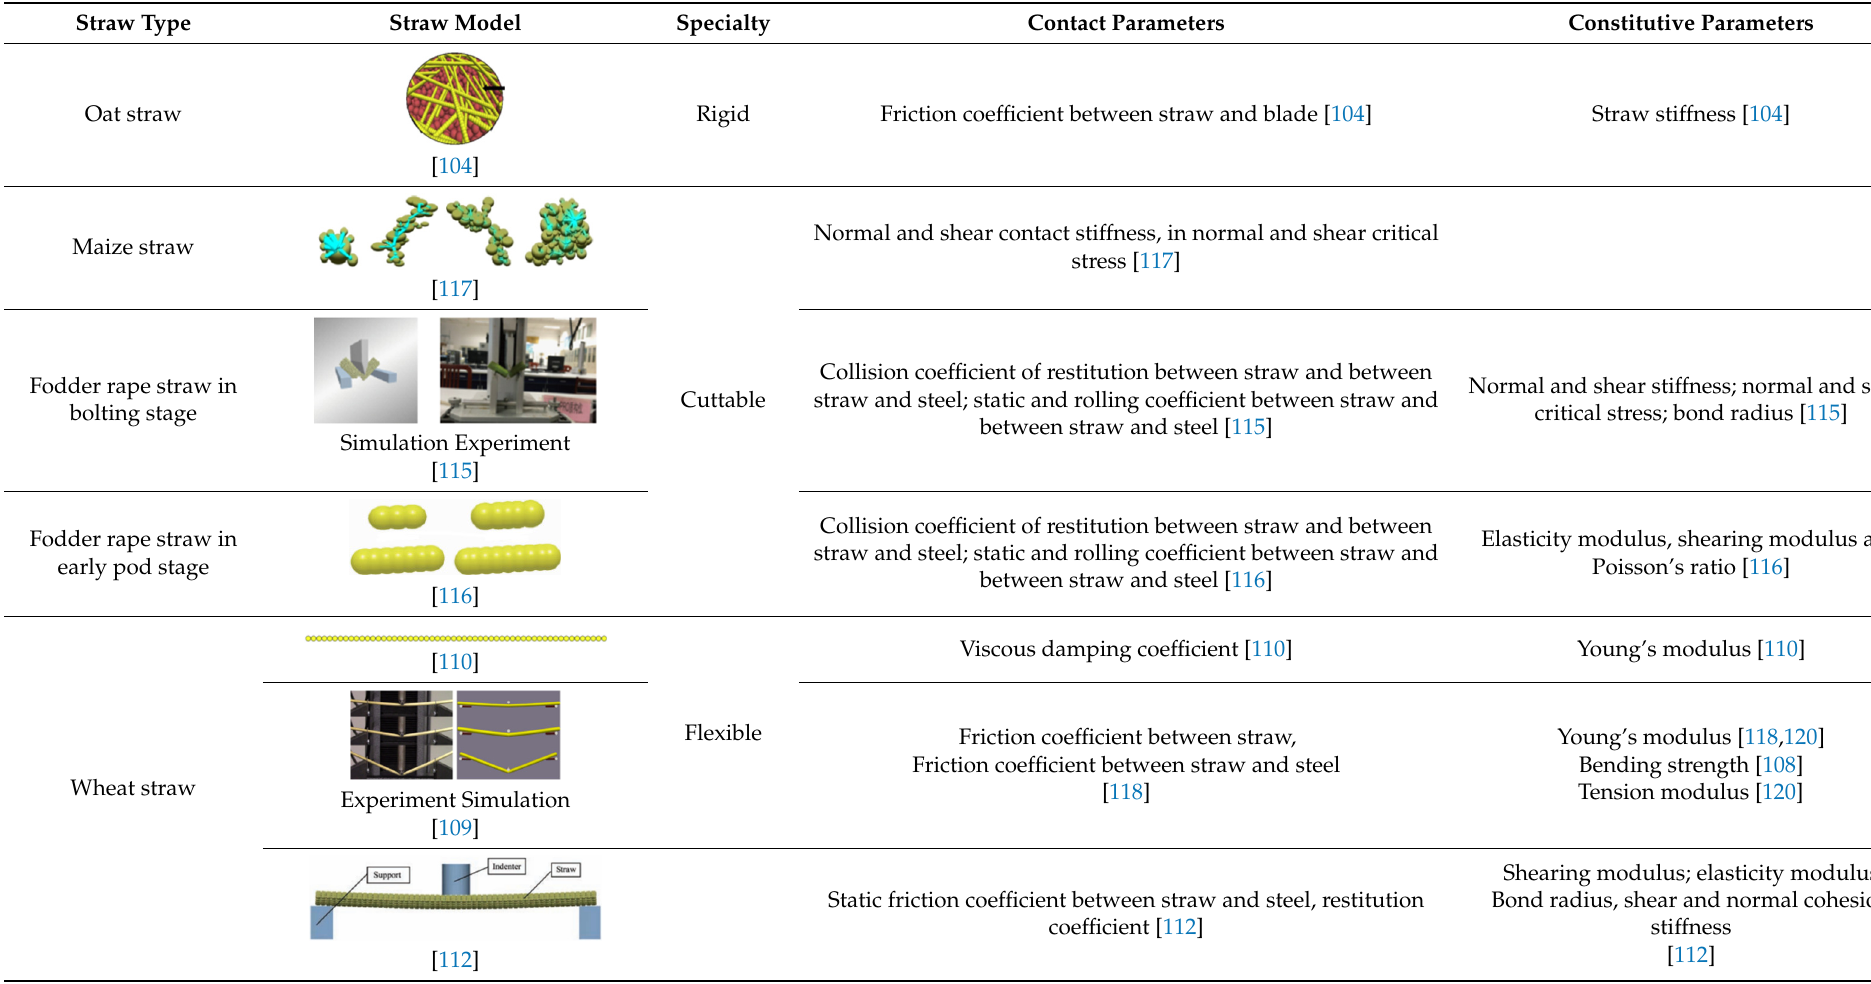
Table 3. DEM models and key parameters of straw.